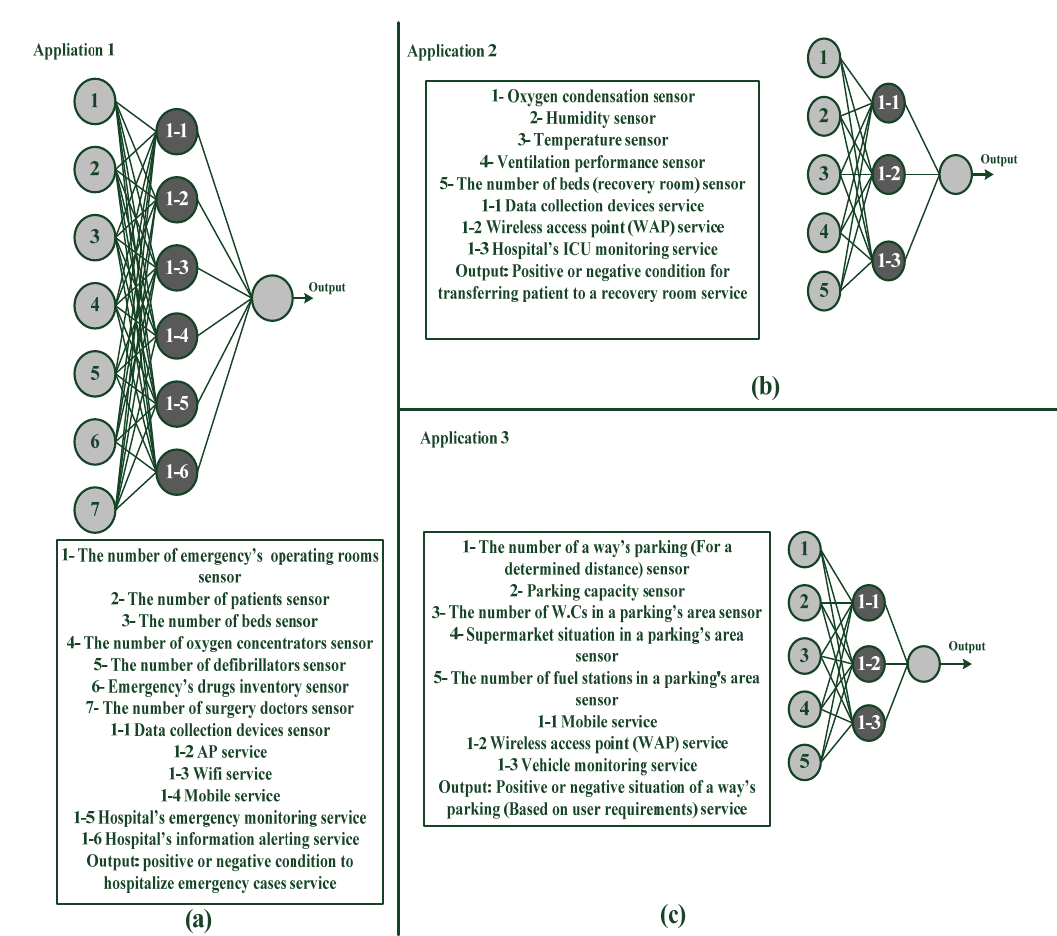
Figure 2. The defined different IoT-based applications and mapping their nodes onto the NNs’ neurons; ( a ) Hospitals’ emergency unit facilities (Application 1); ( b ) Hospitals’ ICUs and recovery rooms facilities (Application 2); ( c ) Roadside parking facilities (Application 3).